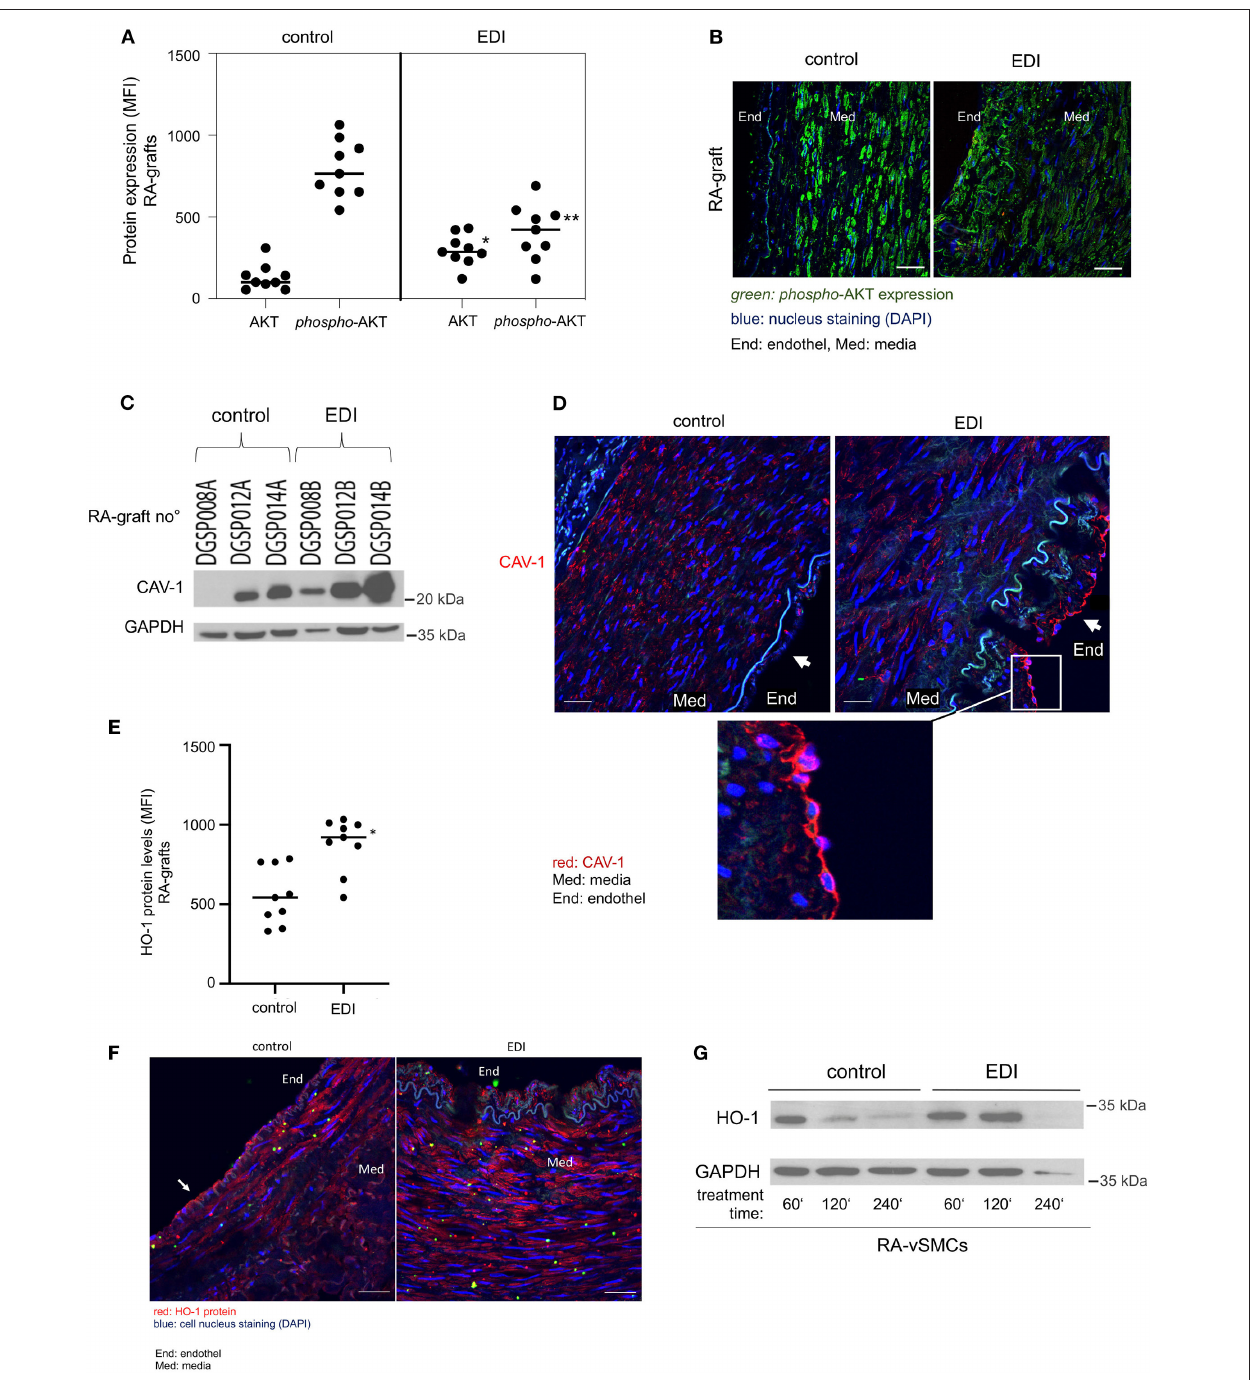
FIGURE 4 | Mediated increased capacity, Caveolin-1 (CAV-1) and heme oxygenase-1 (HO-1) by EDI treatment of vascular tissues. EDI or RL (control) treated patients’ specimens were stained for phosphorylated- AKT( p -AKT) and AKT protein expression. Analysis done by immunofluorescence (IF) staining. (A) Statistical calculations and (B) representative images were given. ** p < 0.01. MFI, mean fluorescence intensity. green, p -AKT; blue, nuclei staining (DAPI). End, endothelium; Med, media. ( C + D ) CAV-1 protein expression measured by Western blot (WB) and IF analysis. (C) Representative CAV-1WB of RA graft protein extracts (RA graft no ◦ ) after EDI treatment compared to control treatment. GAPDH protein was used as internal control. The last letter of RA-graft no ◦ indicated treatment (A = control, B = EDI solution). (D) CAV-1 IF staining after EDI treatment compared to control group. red, CAV-1; blue, cell nuclei staining (DAPI); Med, media; End, endothel. (E–G) HO-1 expression after EDI or RL exposure in RA specimens of the same patient. (E) Statistical analysis of HO-1 protein expression measured by IF staining. * p < 0.05. (F) A representative IF image is given. End, endothel; MED, media. red, HO-1; scale bar, 20 µ m. (G) RA-vSMC were treated with EDI vs. RL. Treatments were done in a time dependent